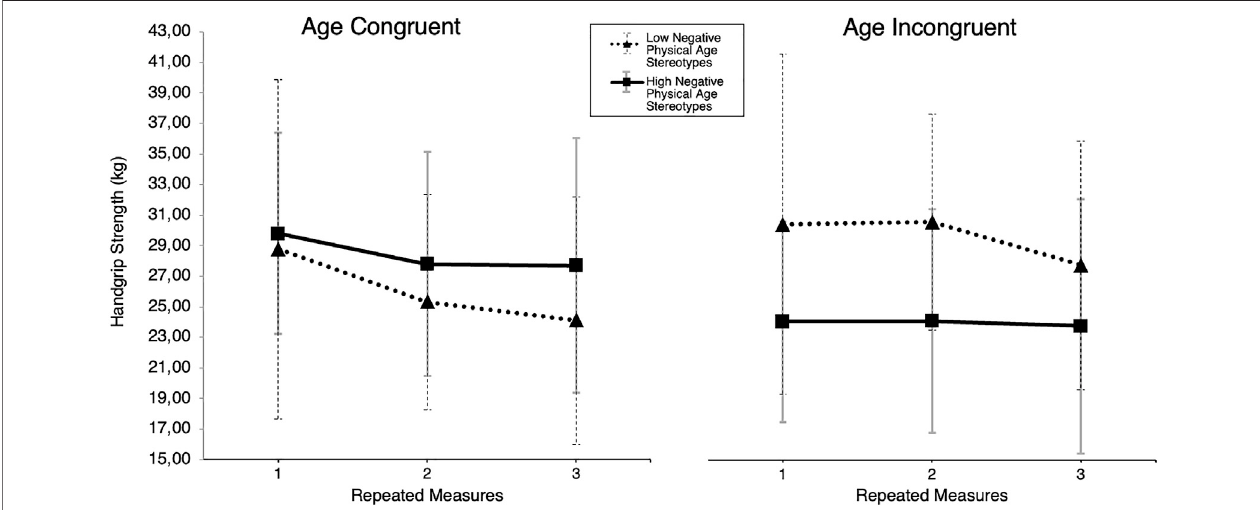
FIGURE5| Handgripstrengthbyexperimentalconditionandphysicalagegroupstereotypenegativity.Note.Handgripstrengthscoresofyoungsampledisplayed separatelyfortheYA y (youngavatar)andOA y (oldavatar)subgroupsoverthreerepeatedmeasureswithseparategraphsfor(mediansplit)lowandhighnegativedomain- matched (physical)